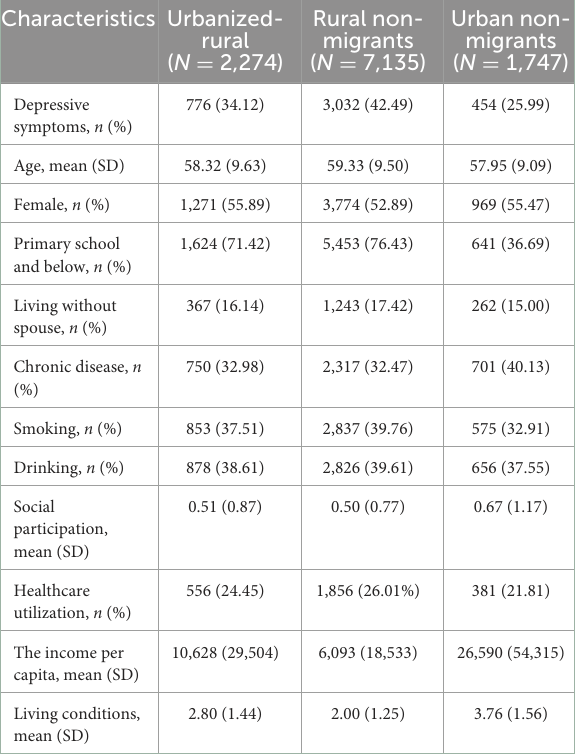
TABLE 1 Characteristics of participants ( N =